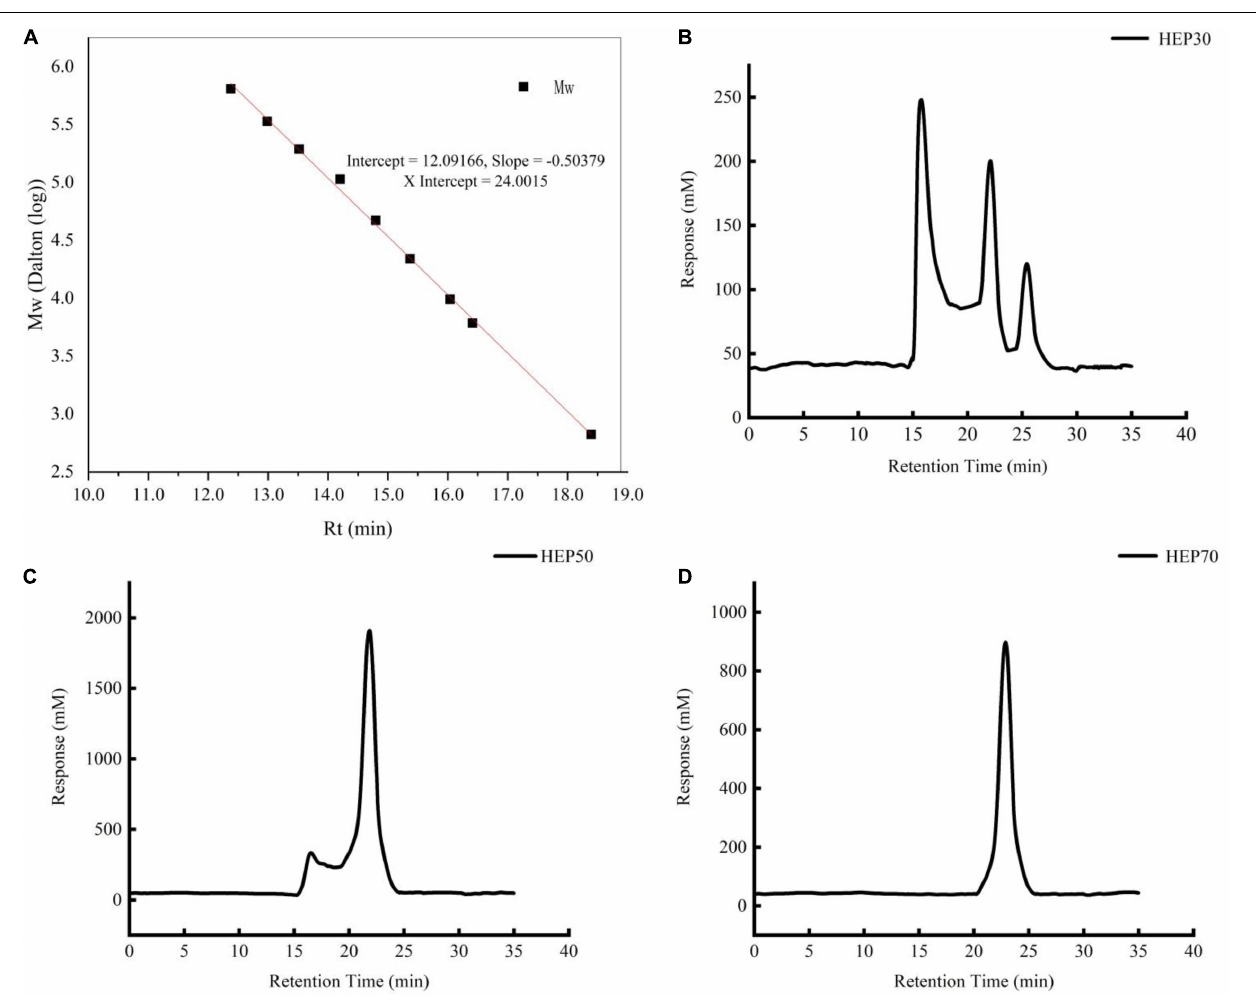
FIGURE 1 | The molecular weight of standard curve. (A) Hericium erinaceus polysaccharides (HEP)-30 (B) , HEP-50 (C) , HEP-70 (D) .